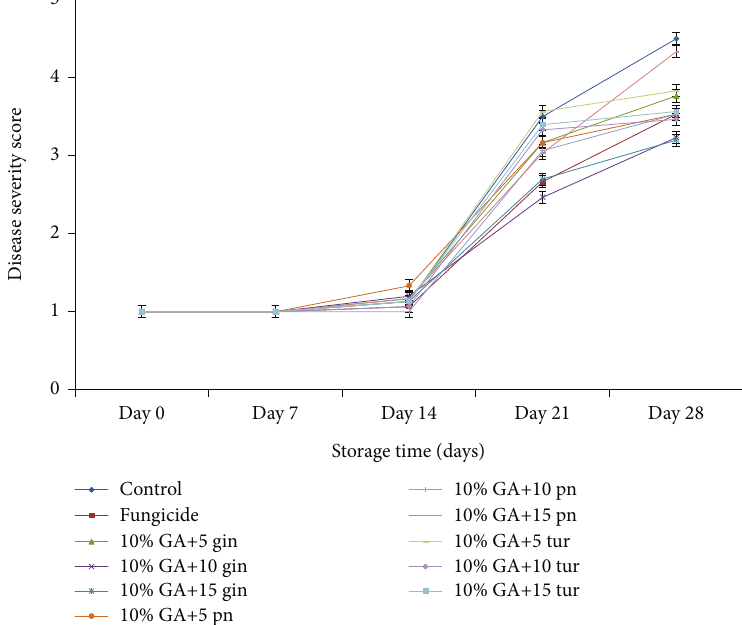
Figure 4: E ff ect of 10% GA incorporated with plant extracts at di ff erent concentrations on disease severity during cold storage for 28